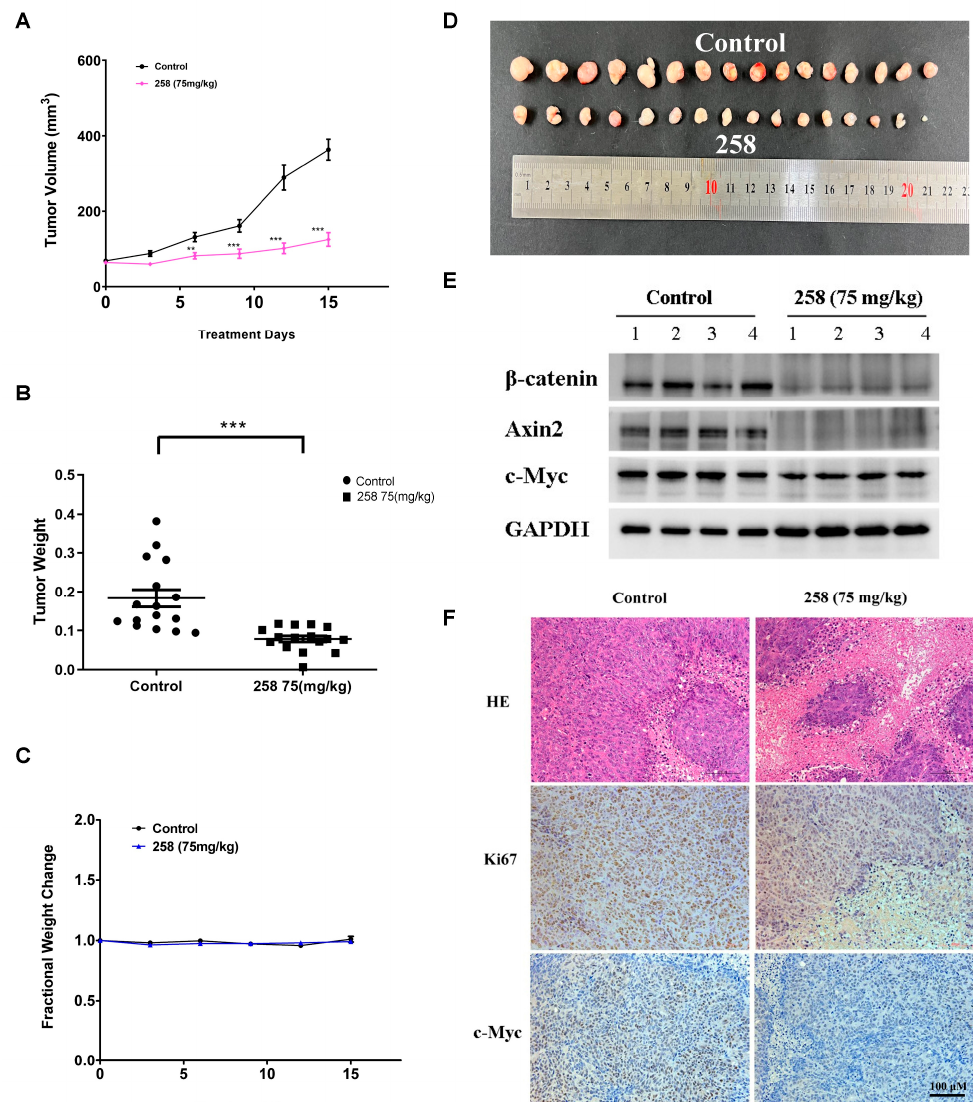
Figure 6. In vivo e ff ects of CX258 on CRC cell xenografts in SCID mice. ( A – C ) The chalcone deriva- tive CX258 inhibited DLD-1 xenograft growth in SCID mice without overall toxic e ff ects in terms of body weight. ** p < 0.01, *** p < 0.001 vs. Control. ( D ) Tumors after 2-week treatment. ( E ) Protein levels of Wnt signaling pathway-related proteins were analyzed by western blot. GAPDH was used as a loading control. ( F ) H&E, Ki67 and c-Myc staining of tumor